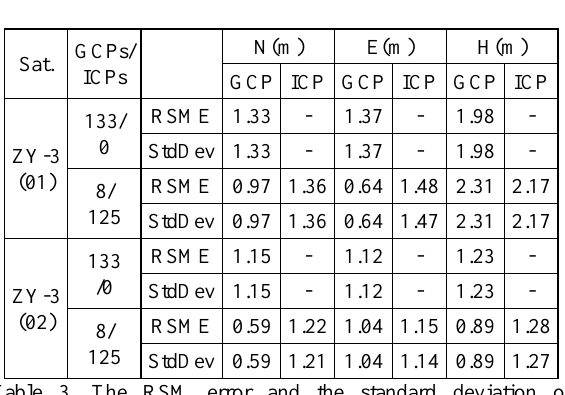
Table 3. The RSM error and the standard deviation of GCPs/ICPs in the ZY-3 triplet stereo images with affine compensation model adjustment